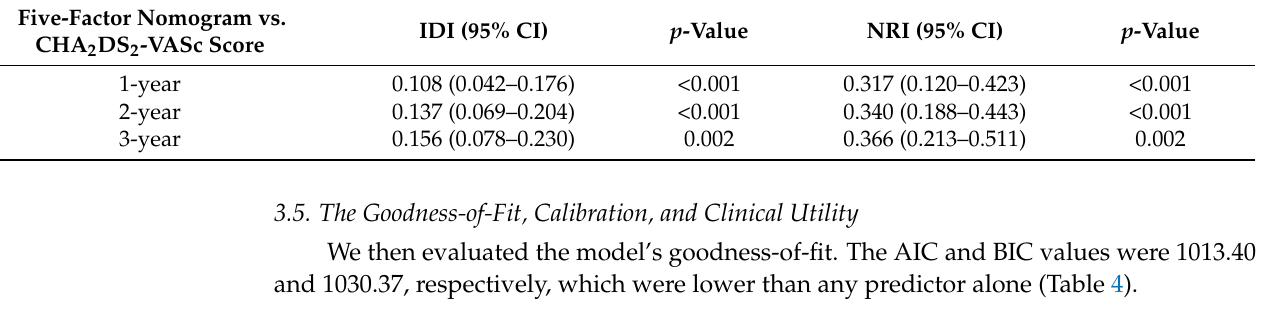
Table 3. Overall evaluation of the five-factor nomogram and the CHA 2 DS 2 -VASc score. Five-Factor Nomogram vs.